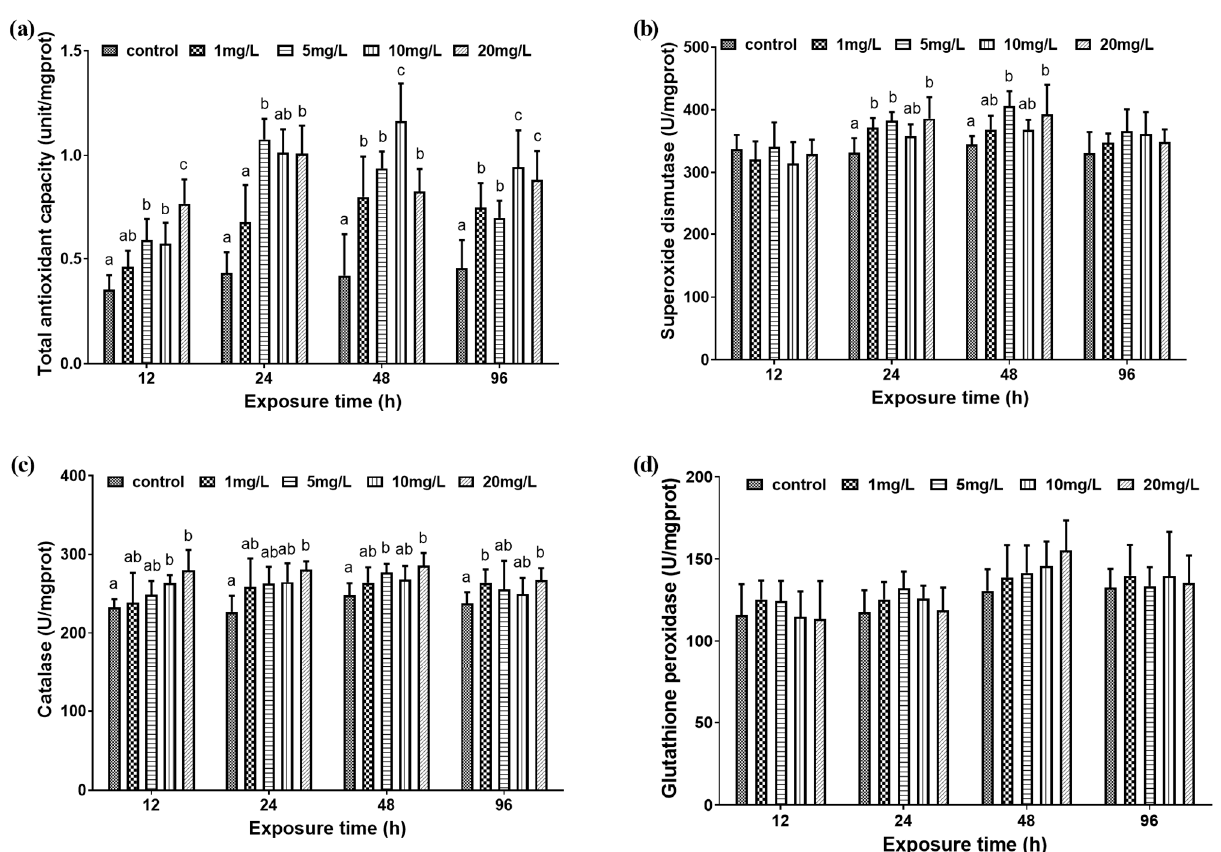
Figure 2. Liver antioxidant capacity of M. amblycephala juveniles exposed to different nitrite concen- trations from 12 h to 96 h. Data are expressed as mean ± SD (n = 3). ( a ) Total antioxidant capacity value; ( b ) superoxide dismutase activity; ( c ) catalase activity; ( d ) glutathione peroxidase activity. Different letters represent significant differences among treatments ( p < 0.05).